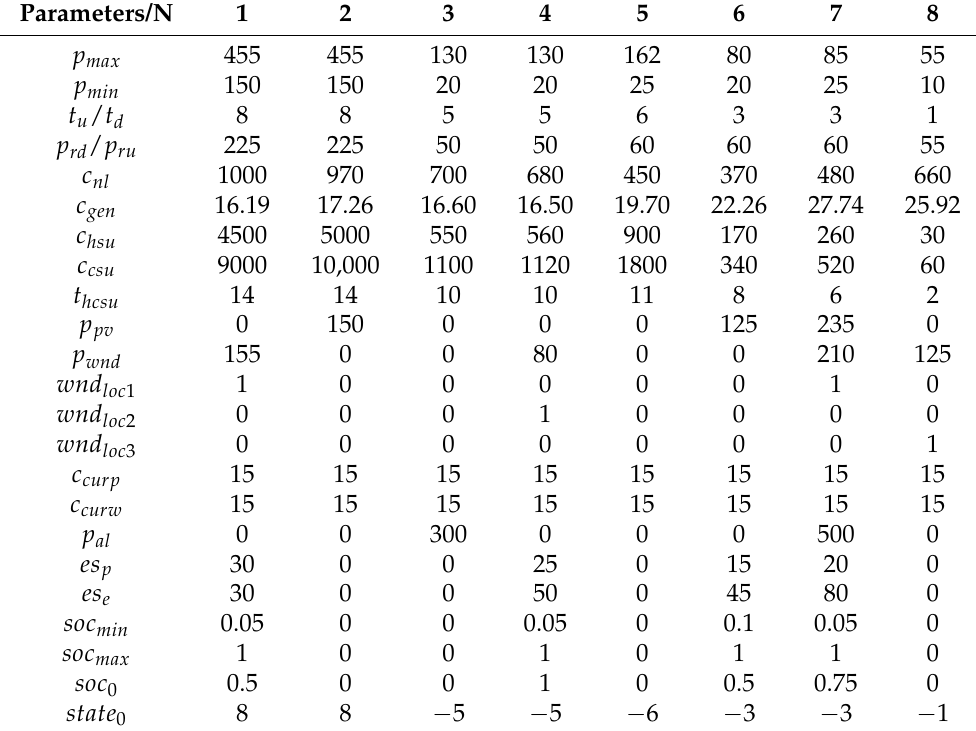
Table A4. Table representing the parameters of sources from TS.